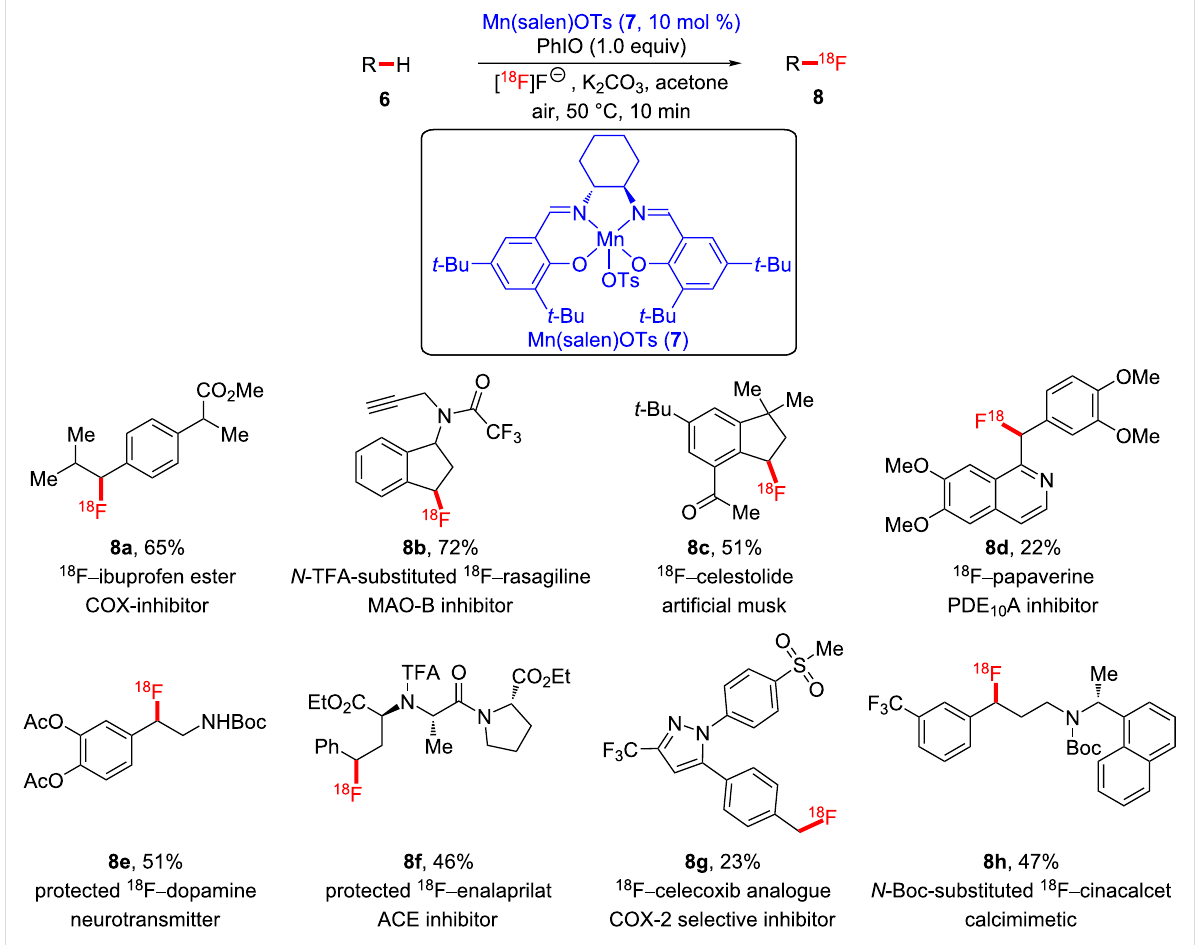
Scheme 2: Late-stage radiofluorination of biologically active complex molecules.